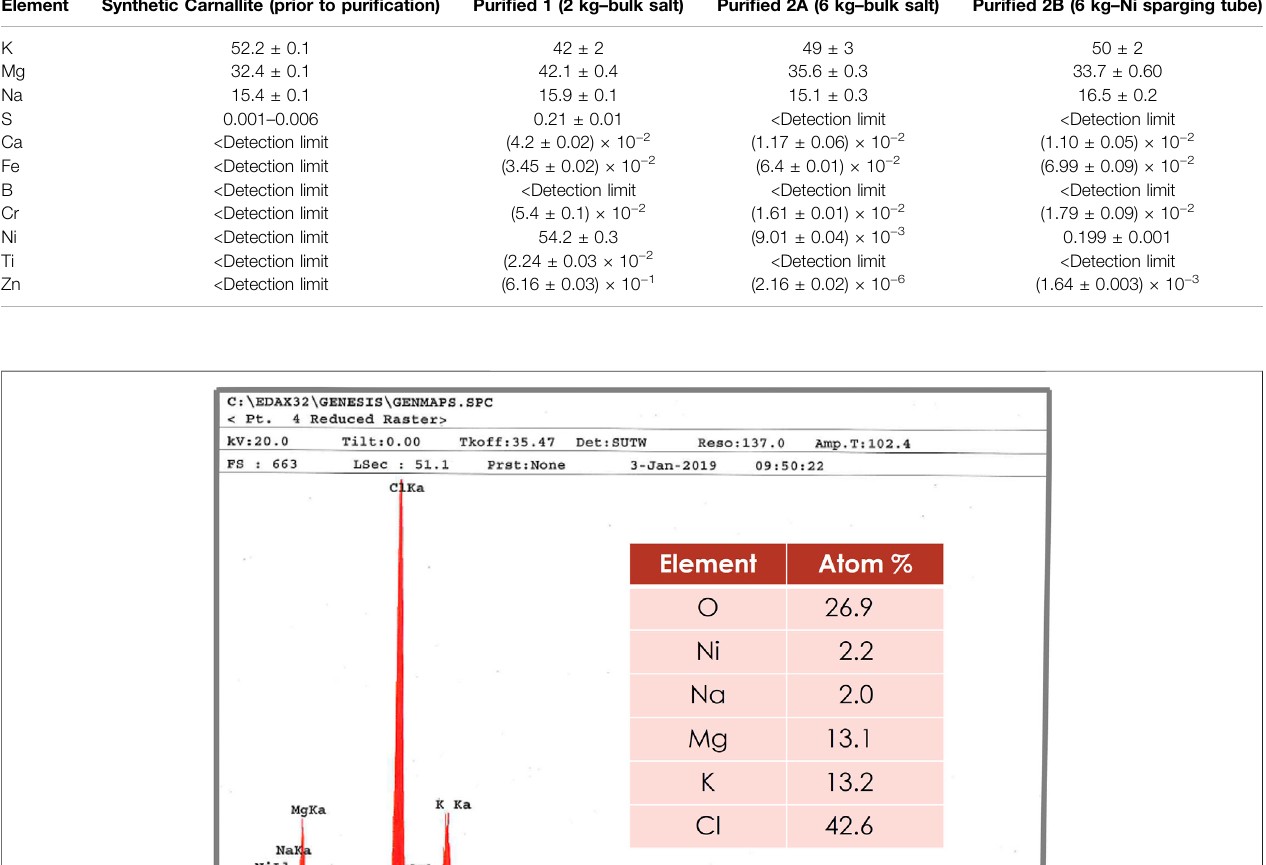
Frontiers in Chemical Engineering |